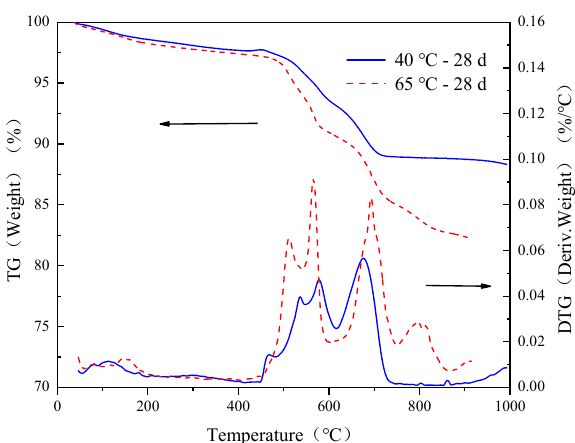
Temperature （ ℃ ） Figure 9. The effect of curing temperature (40 °C and 65 °C) on the TGA/DTA at 28d. It can be seen from Figure 10 that at 28d, the strength of CH at 65 °C was 18 (1494CPS), 47 (1508CPS) and 51°2-theta (2236CPS), which was higher than 18 (1470CPS), 47 (1401CPS) and 51°2-theta (2193CPS) at 40 °C . This means that at 28d, the higher the temperature, the more hydration products will be produced, and the higher the strength should be, which is consistent with the thermal analysis results, but contrary to the change law of strength. Therefore, the main factor affecting the strength is not the amount of hydration products.